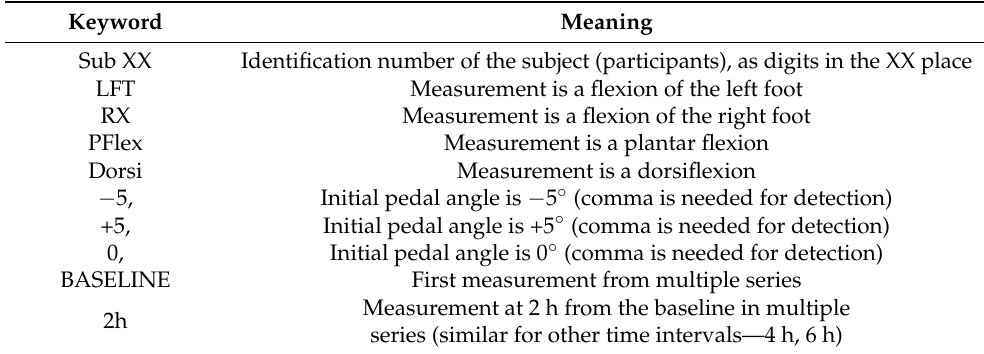
Table 1. Keywords in filenames for detection of the measurement characteristics from index